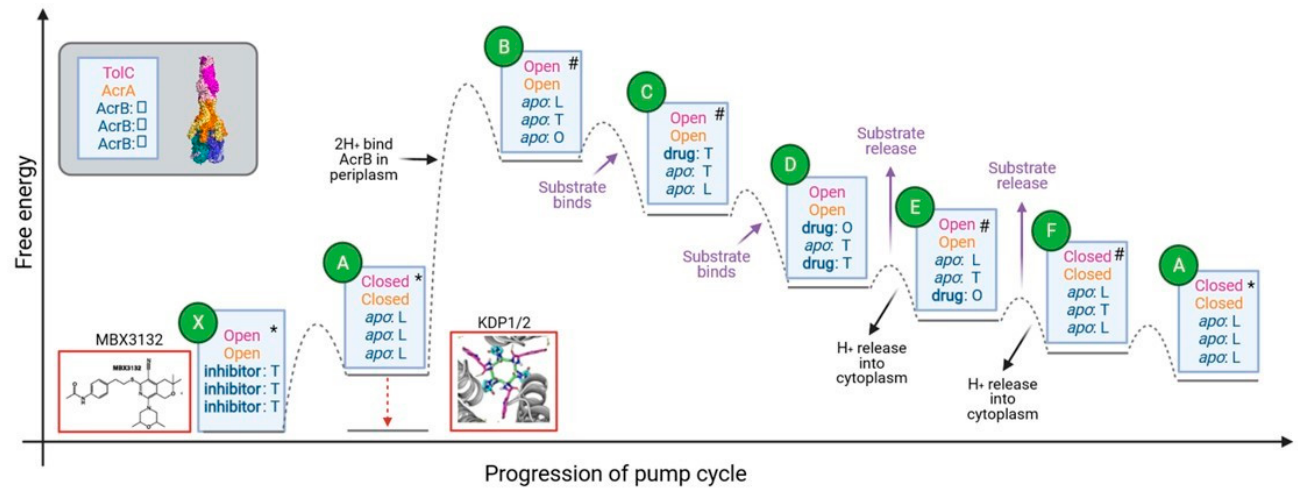
Figure 8. Proposed energy transitions during the AcrAB-TolC pump cycle. Qualitative energy diagram with relative energy levels of predicted states in the pump cycle. Text in blue boxes describes the conformations and the ligand binding states of TolC, AcrA, and the three AcrB subunits from top to bottom. Boxes outlined in red show pump inhibitors. * indicates states where high-resolution structures of the whole pump assembly exist. # indicates where high-resolution structures of AcrB in the specified conformation exist. The dotted lines indicate energy barriers to transition between the connected species, with maxima indicating transition states. AcrB subunit conformations are L = Loose, T = Tight, O =